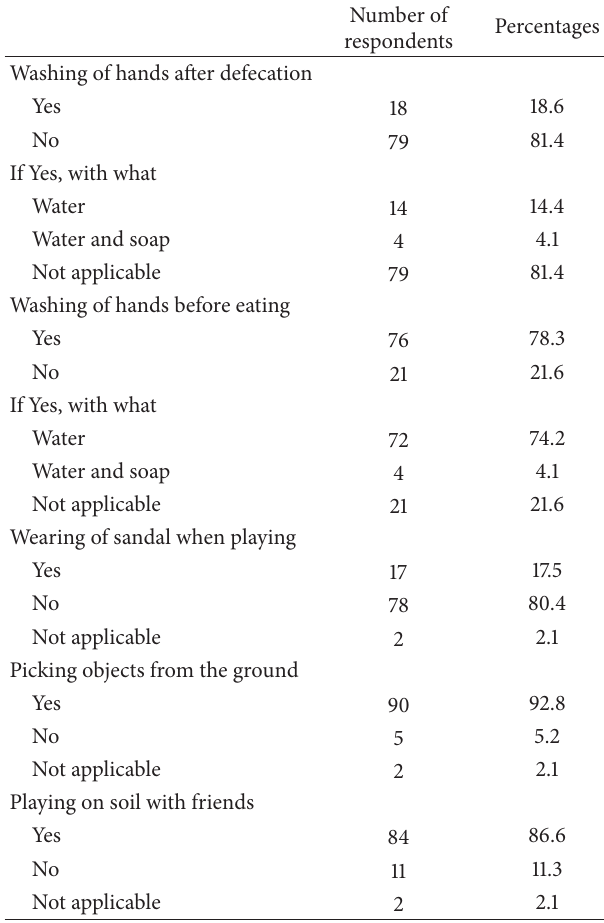
Table 8: Water and sanitary conditions of the surveyed preschool aged children.